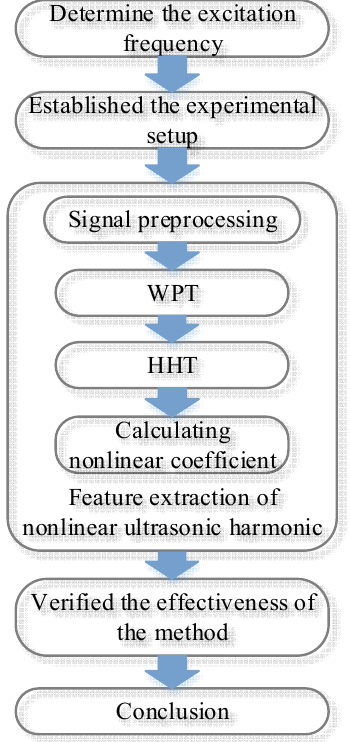
Figure 2. The schematic illustration of the evaluation process for lined anti-corrosion pipes.